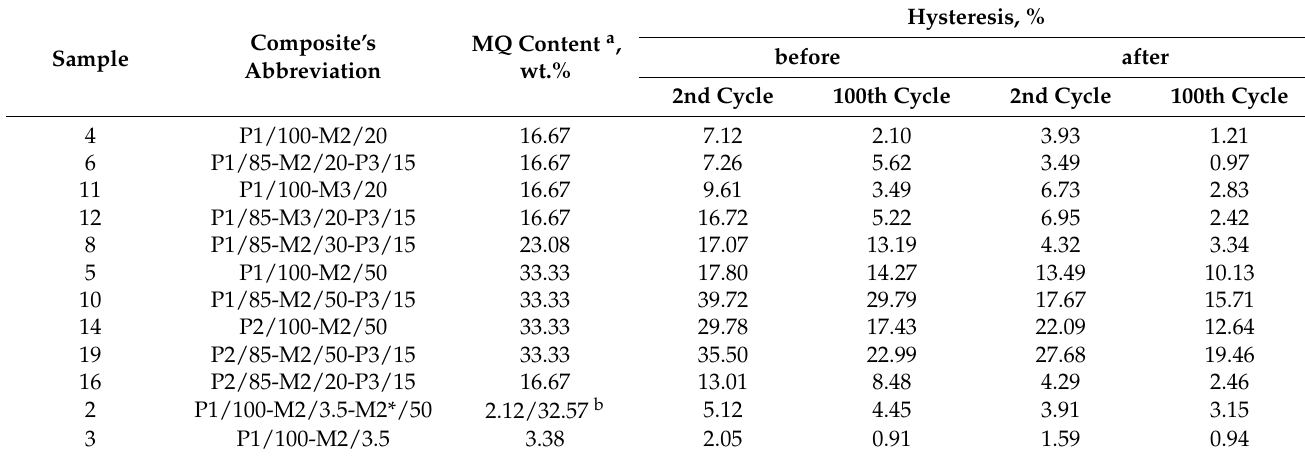
Table 4. Dynamics of changes in mechanical hysteresis before and after HT in the specimens